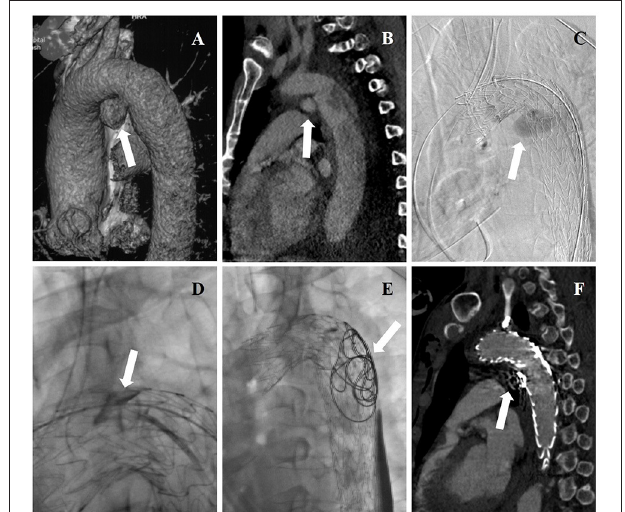
FIGURE 2 | (A) Three-dimensional reconstructions of pre-operative CTA showing concomitant aortic arch pseudoaneurysm (arrow) of traumatic aortic dissection. (B) Pre-operative CTA showing the entry tear (arrow) of aortic dissection. (C) Intraoperative DSA showing deployment of aortic stent graft and CGs, and angiography through a pre-road catheter to FL revealed intraoperative EL-I (arrow). (D) Onyx glues were injected into gutters (arrow) through a microcatheter. (E) Coils and Onyx glues were deployed into FL (arrow) through a pre-road catheter. (F) The aortic dissection and pseudoaneurysm were entirely excluded while endoleak disappeared (arrow) in post-operative